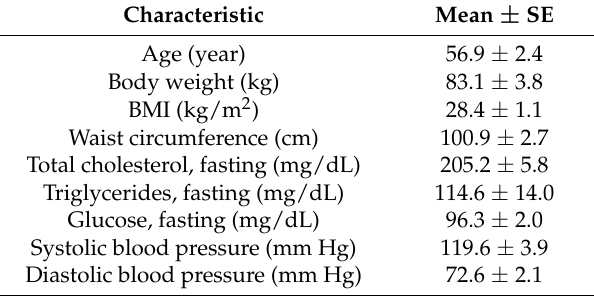
Table 1. Characteristics of study subjects prior to the intervention ( n = 18, 9 men and 9